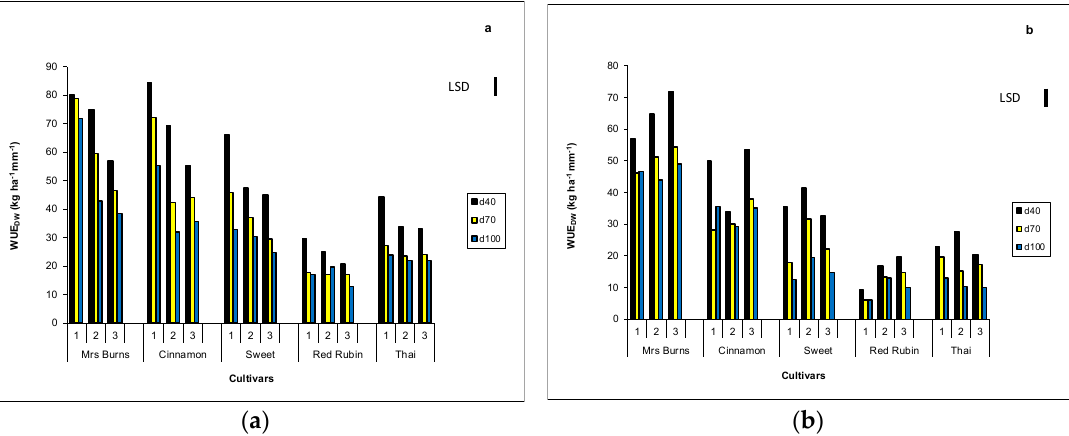
Figure 4. Water use efficiency (WUE) of the five basil cultivars at the three irrigation levels (d 40 , d 70 , and d 100 ), at the three growing stages of the two growing seasons 2015 ( a ) and 2016 ( b ). Data presented are mean values; vertical bar corresponds to the least significant difference (LSD).